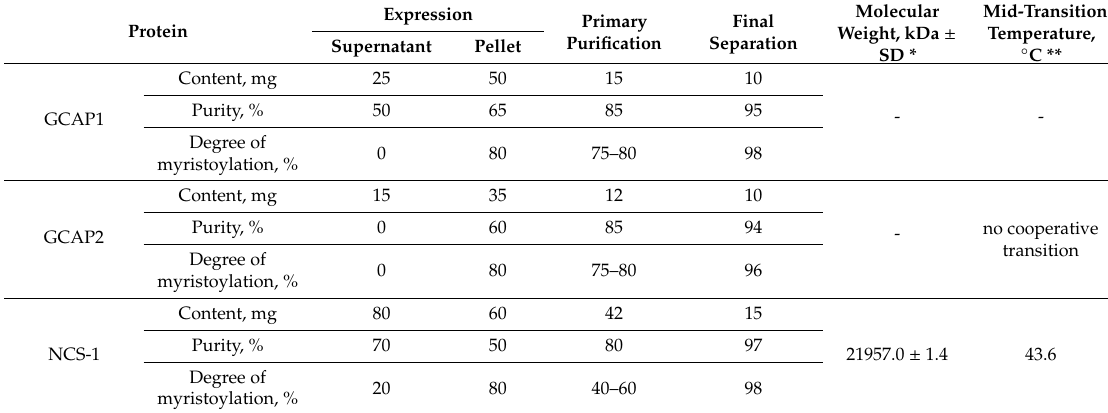
8 of 22 Table 1. Quantitative characteristics of NCS expression and purification. Primary purification steps: Phenyl Sepharose for NCS-1, NCALD and recoverin; Butyl Toyopearl for GCAPs. Final separation steps: Butyl Sepharose for NCS-1, GCAP1 and GCAP2. Protein